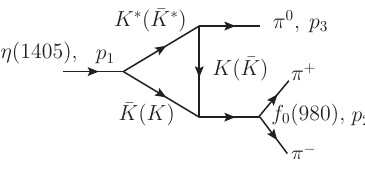
Figure 6. In the hypothetical case of the stable K ∗ = K ∗ (892) meson the logarithmic singularity appears in the imaginary part of the amplitude of this triangle diagram in the η (1405) meson region. However, its contribution can be correctly estimated only in view of the finite width of the K ∗ [16,